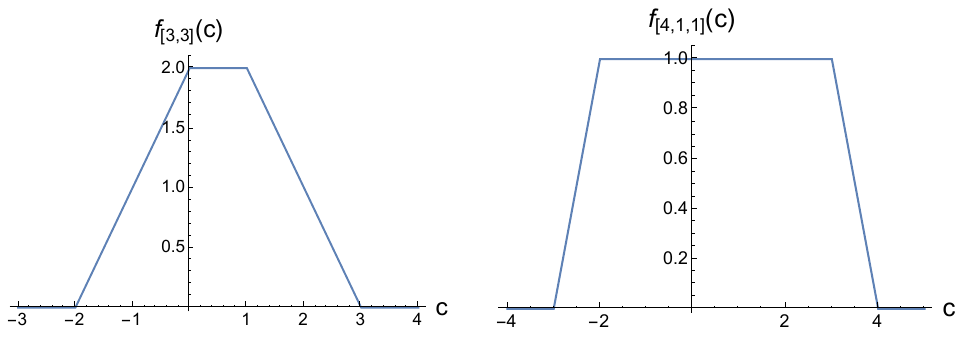
Figure 8 . The CDF plots for the partitions degenerate in